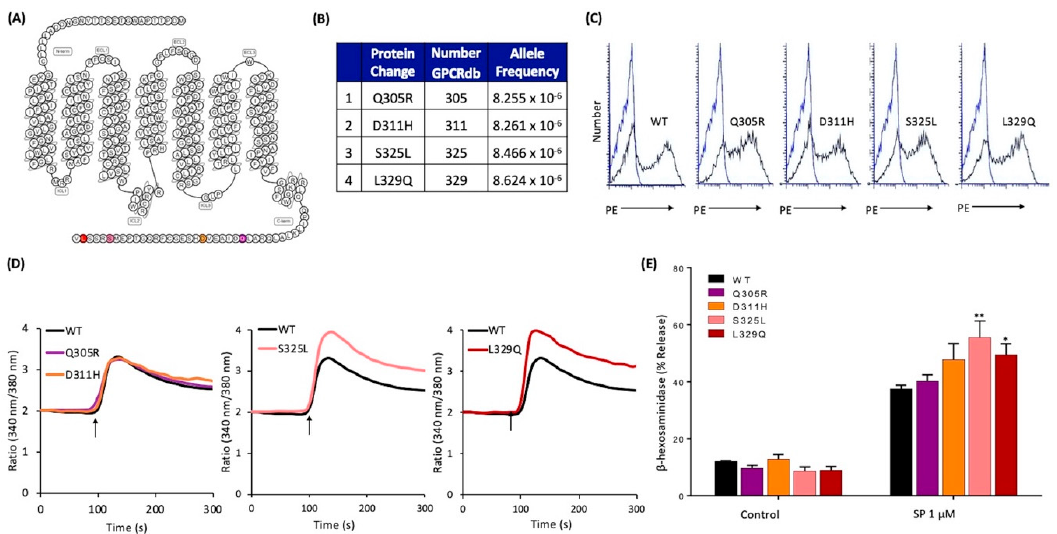
Figure 6. E ff ects of naturally occurring MRGPRX2 variants within the receptor’s carboxyl-terminus (Q305R, D311H, S325L, and L329Q) on SP-induced responses in transiently transfected RBL-2H3 cells. ( A ) Snake diagram of secondary structure of MRGPRX2. Each circle represents amino acid residue with one letter code. Solid purple, orange, pink, and red backgrounds denote the naturally occurring missense variants Q305R, D311H, S325L, and L329Q, respectively; ( B ) amino acid change for each MRGPRX2 variant with allele frequency; ( C ) cell surface expression of WT-MRGPRX2 and its variants was determined by flow cytometry using PE-anti MRGPRX2 antibody. Representative histograms for WT / variant (black line) and control untransfected cells (blue line) are shown; ( D ) cells expressing WT-MRGPRX2 and its variants were loaded with Fura-2 and intracellular Ca 2 + mobilization in response to SP (1 µ M) was determined. Data shown are representative of three independent experiments; ( E ) cells were exposed to bu ff er (control) or SP (1 µ M) for 30 min, and β -hexosaminidase release was determined. All data points are the mean ± SEM of at least three experiments performed in triplicate. Statistical significance was determined by a nonparametric t -test. * p ≤ 0.05 and ** p ≤